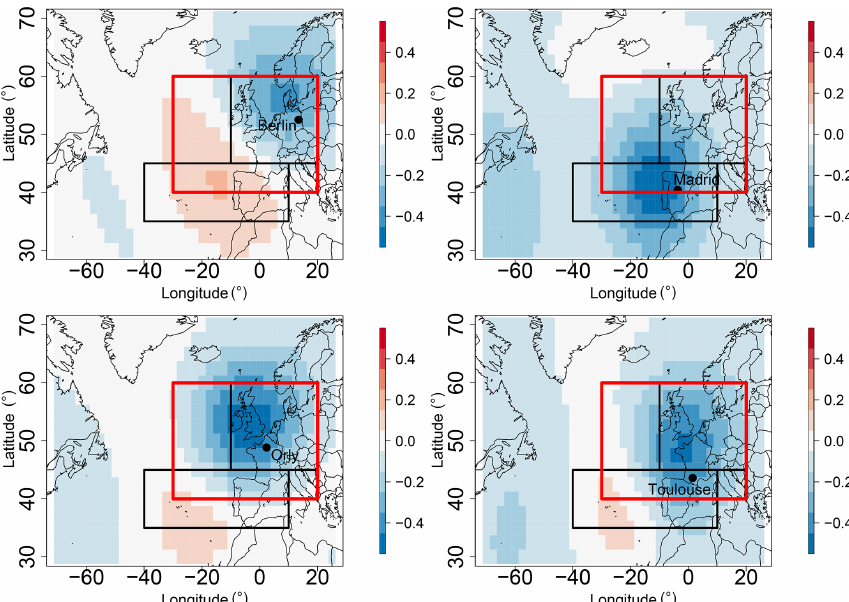
Figure B1. Maps of correlation between Z 500 and precipitation in Berlin, Madrid, Orly, and Toulouse for the period from 1948 to 2019 over the Euro-Atlantic region. The rectangles represent the domains of computation of analogs. The optimized area [30 ◦ W–20 ◦ E; 40–60 ◦ N] is highlighted by the red